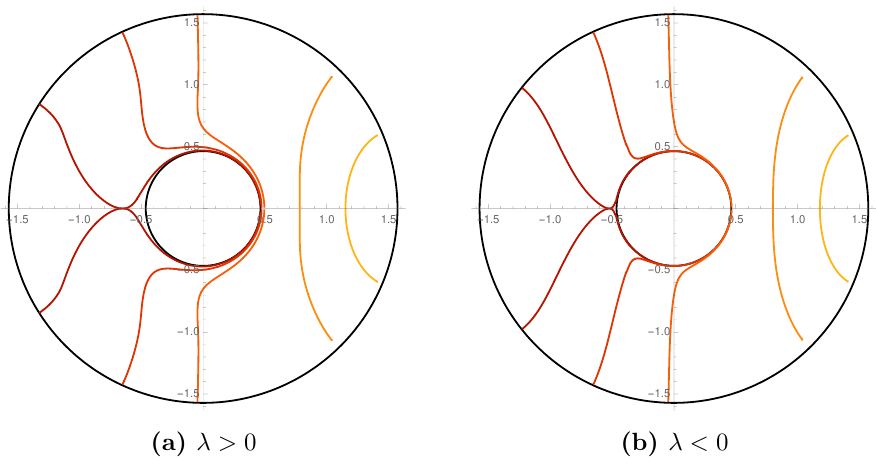
Figure 7. Causal information surfaces (cid:4) A at (cid:12)xed horizon radius r h = 0 : 5 and (cid:12)xed Gauss-Bonnet coupling (cid:21) , for several values of (cid:30) A . (cid:4) A is constructed by shooting the fastest modes with speeds c T for (cid:21) > 0 and c S for (cid:21) < 0 from the lower tip of D [ A ] using several values of angular momentum. The darkest red curve corresponds to the critical surface, where the region A has size (cid:30) (cid:3) (cid:4) A develops a disconnected component. (a) (cid:21) = 0 : 1, (cid:30) (cid:3)